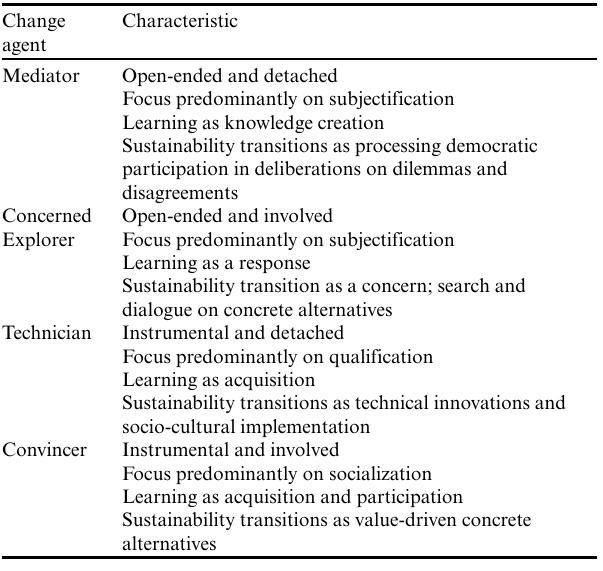
Table 1. Ideal typology and characteristics of sustainability change agents as nonformal